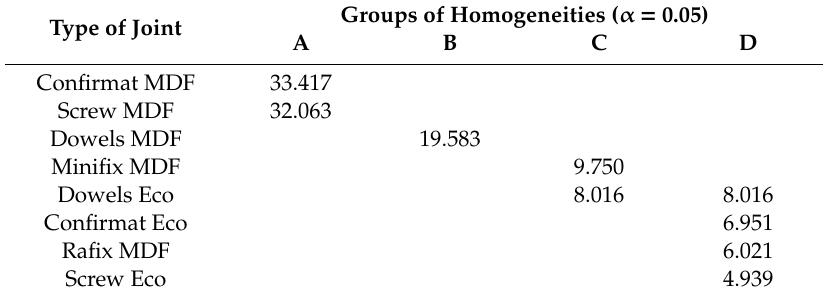
Table 3. Tukey honestly significant di ff erence (HSD) analysis of the di ff erences between the groups